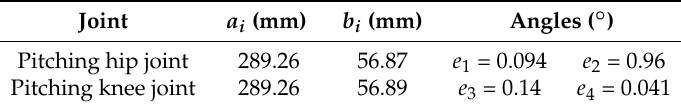
Figure 5. The mechanical structure parameters of the leg. Table 2. The mechanical parameters used in Figure 5.